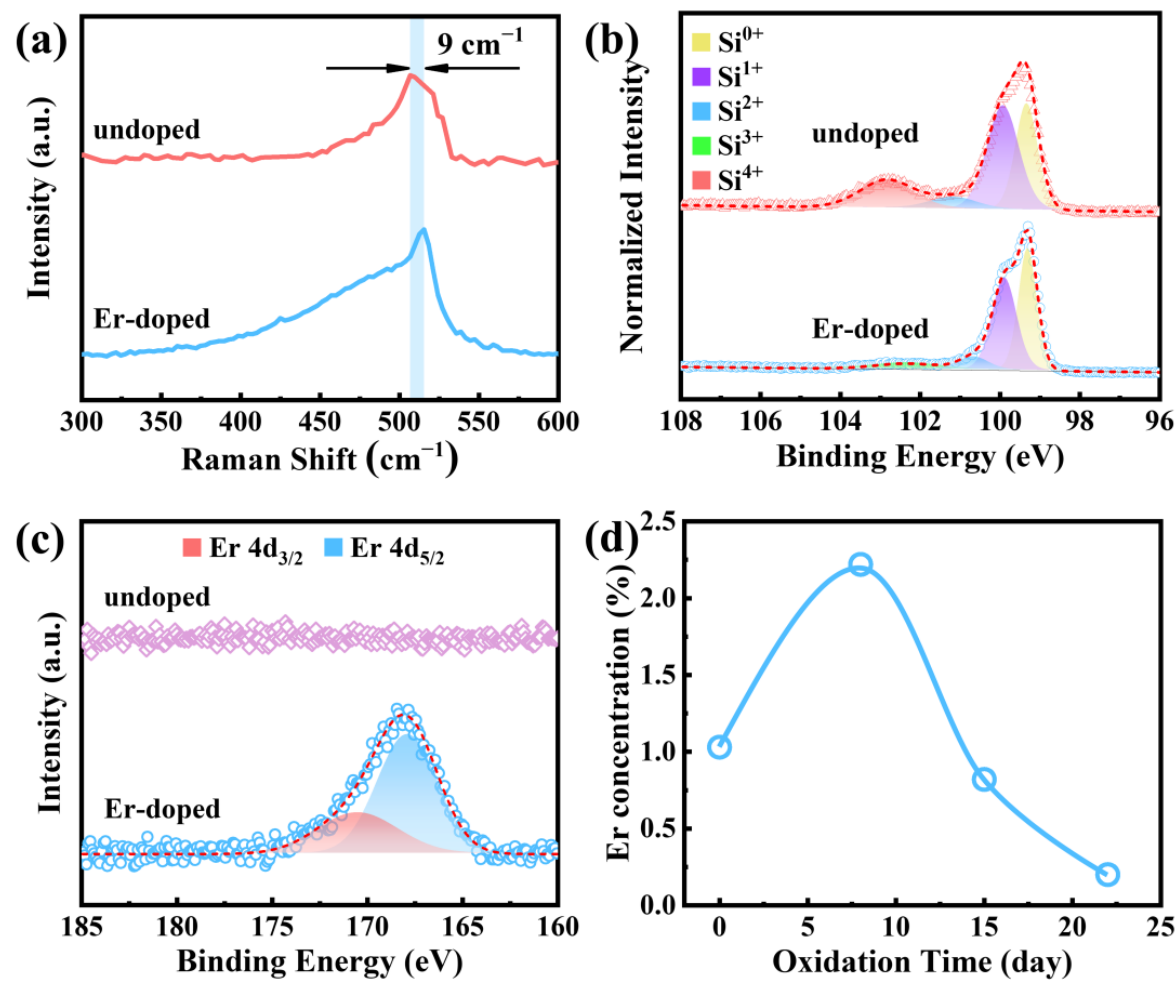
Figure 3. ( a ) Raman spectra, ( b ) Si 2p XPS spectra, and ( c ) Er 4d XPS spectra of Si QDs with pristine and Er hyperdoping. ( d ) Er concentration as a function of oxidation time.